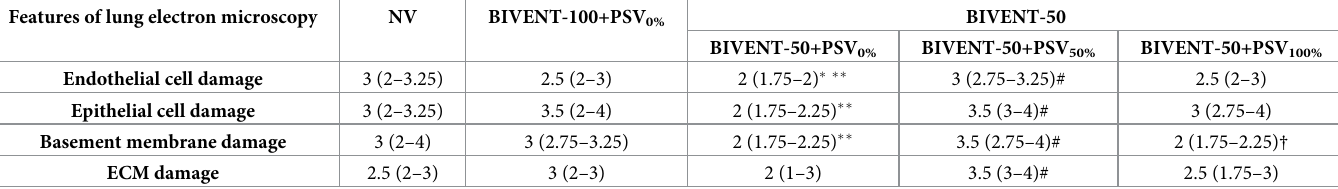
Table 3. Semiquantitative analysis of lung electron microscopy.